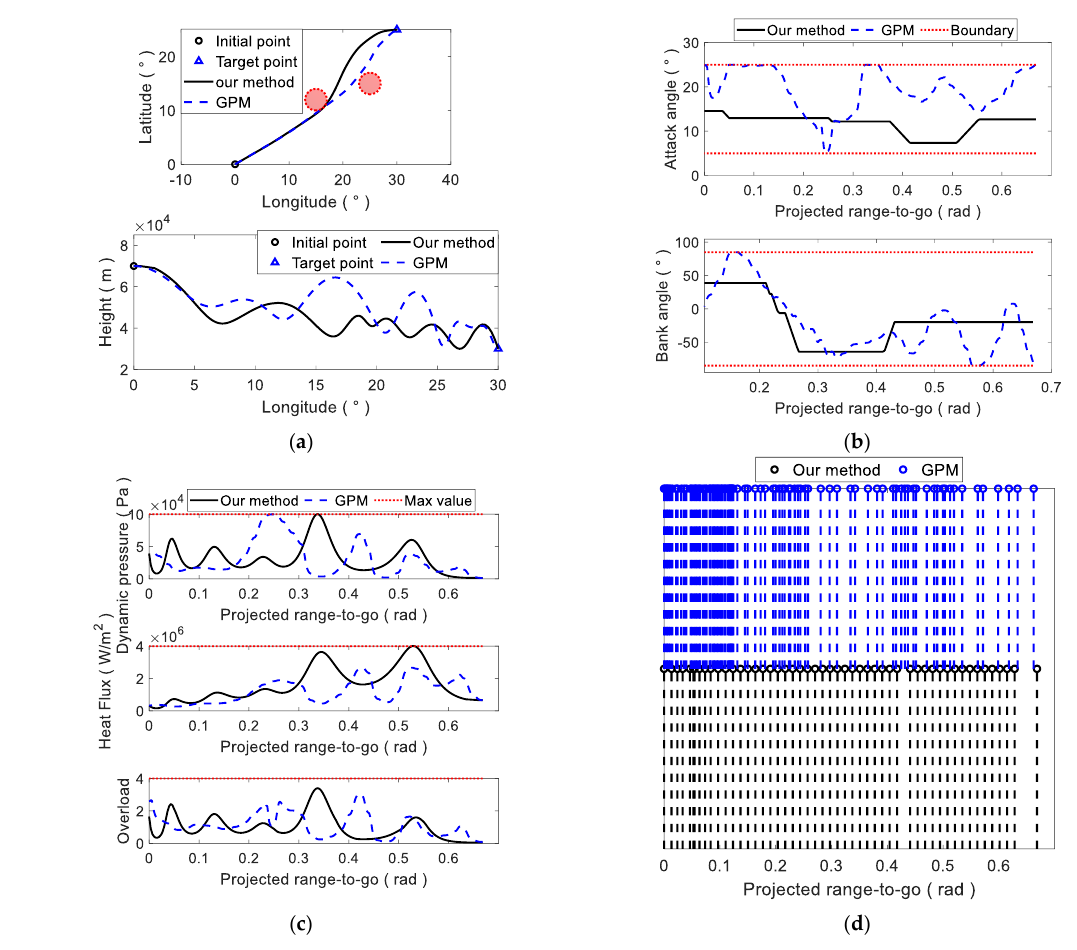
Figure 11. The generation effects of Monte Carlo experiments: ( a ) represents the lateral trajectories; ( b ) represents the longitudinal trajectories; ( c ) represents the landing points location.